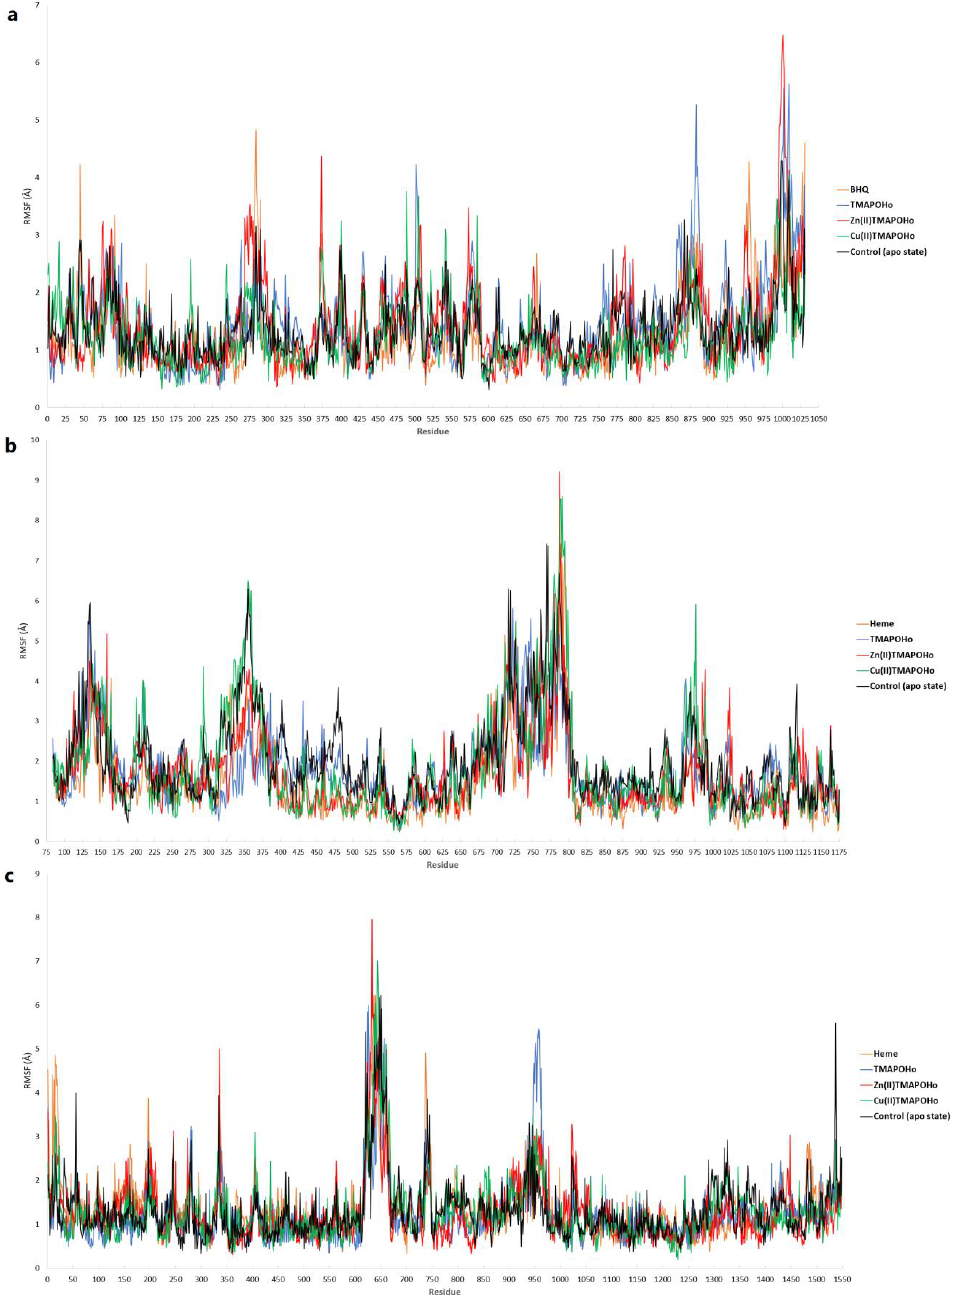
Figure 12. RMSF values per amino acid residue after short MD simulations. ( a ) – SERCA2b; ( b ) – Slo1; ( c ) – SUR2.